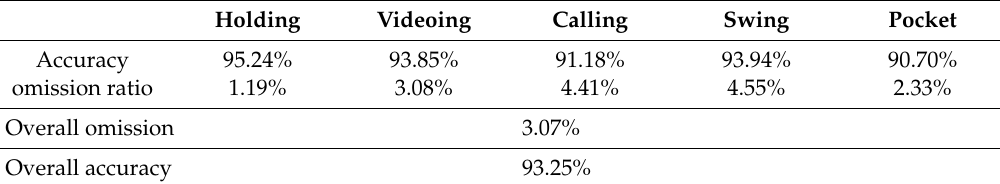
Table 3. Experimental results of mode